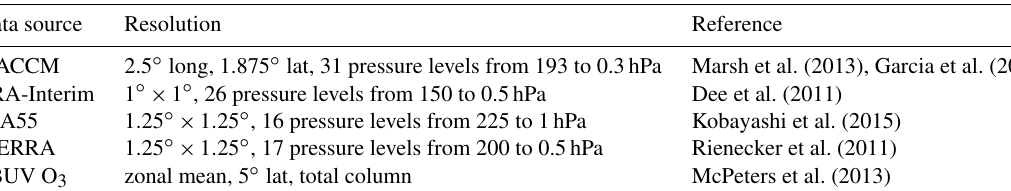
Table 1. Model output, reanalysis products, and ozone data used in this study.